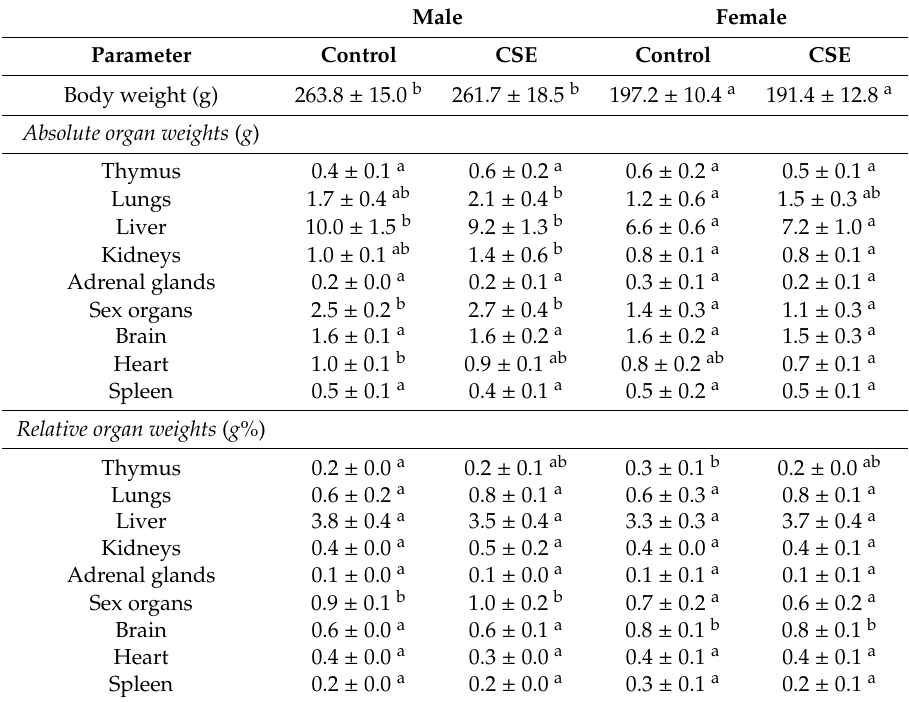
Table 3. Body weights, absolute and relative organ weights (grams) of control rats ( n = 15) and rats treated with CSE (1 g/kg) ( n = 15).